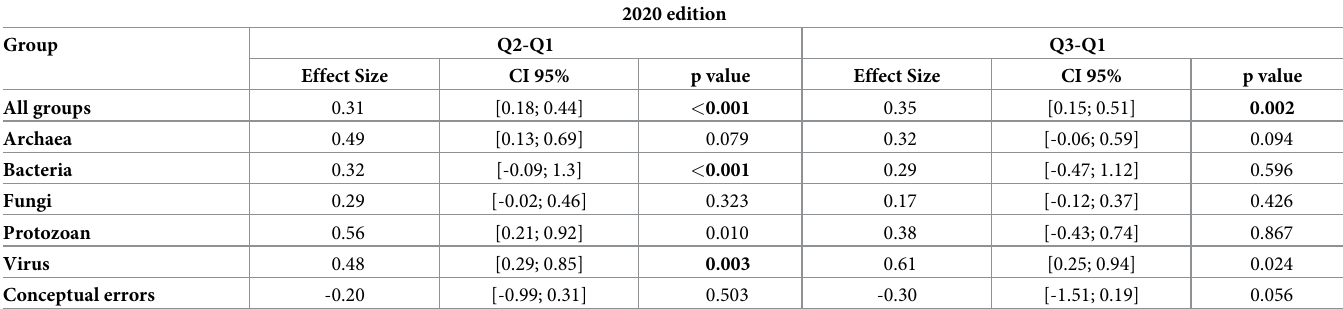
Table 2. Differences in the Shannon index between the questionnaires Q1 and Q2, and Q1 and Q3 for the 2020 edition.